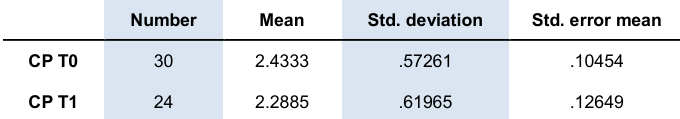
Table 6a: One-sample statistics a − female